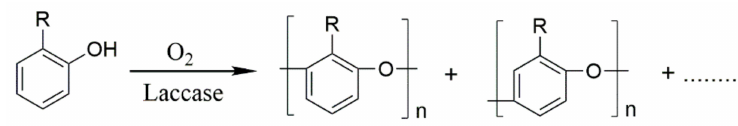
Figure 1. The proposed enzymatic polymerization of phenols assisted by laccase